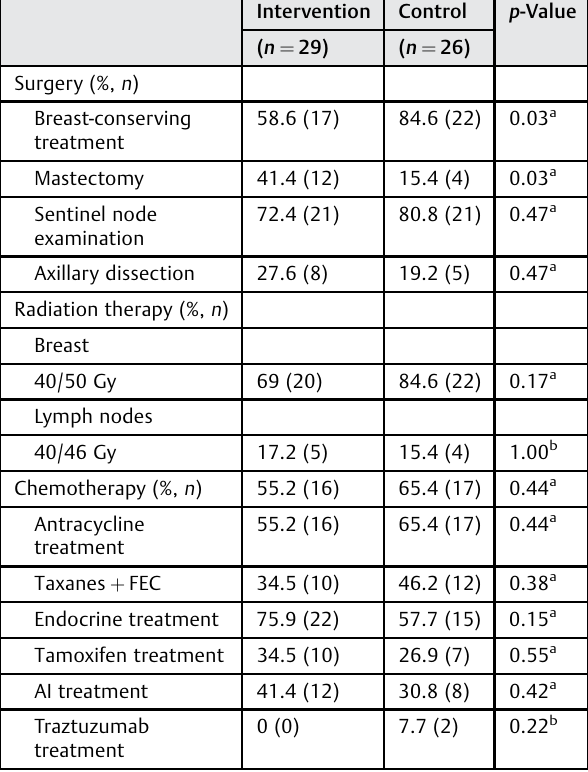
Table 3 Treatment for breast cancer among the patients Intervention